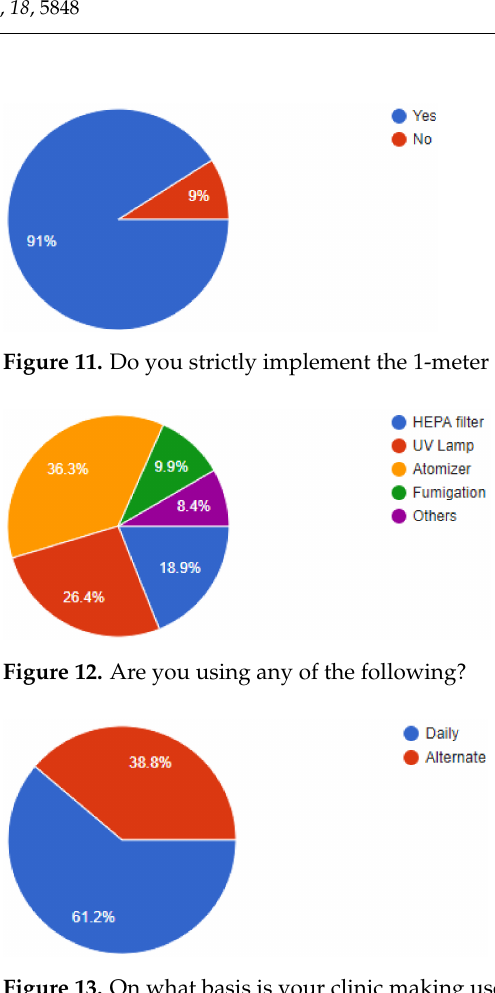
Figure 13. On what basis is your clinic making use of staff?